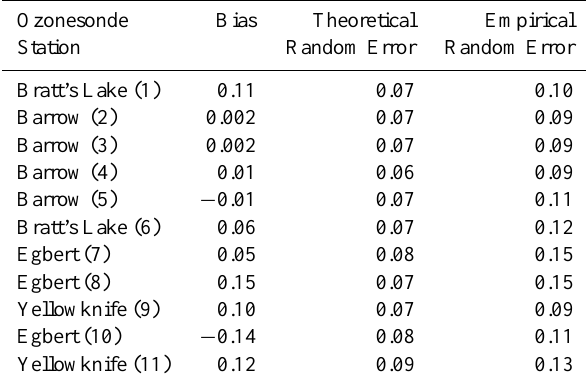
Table 4. Mean bias, theoretical and random errors for V004 TES data